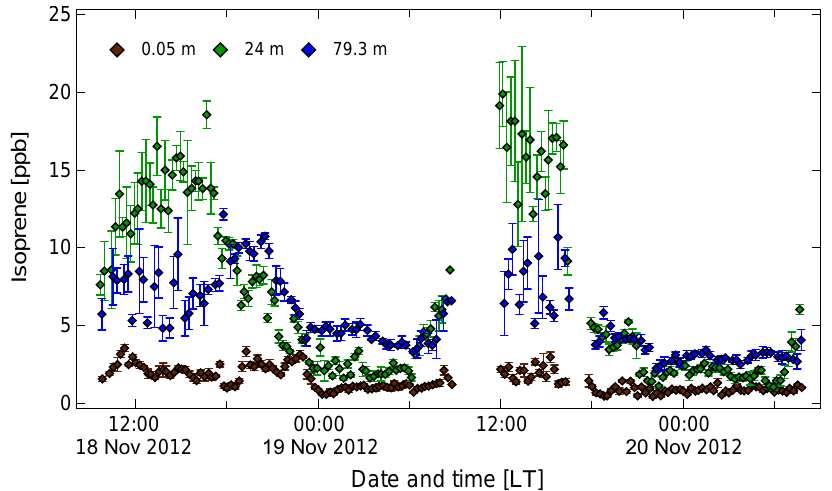
Figure 22. Profiles of isoprene derived from measurements at three different heights (0.05, 24, and 79.3m) below, within, and above the canopy, respectively, in November 2012 (transition period from dry to wet season).